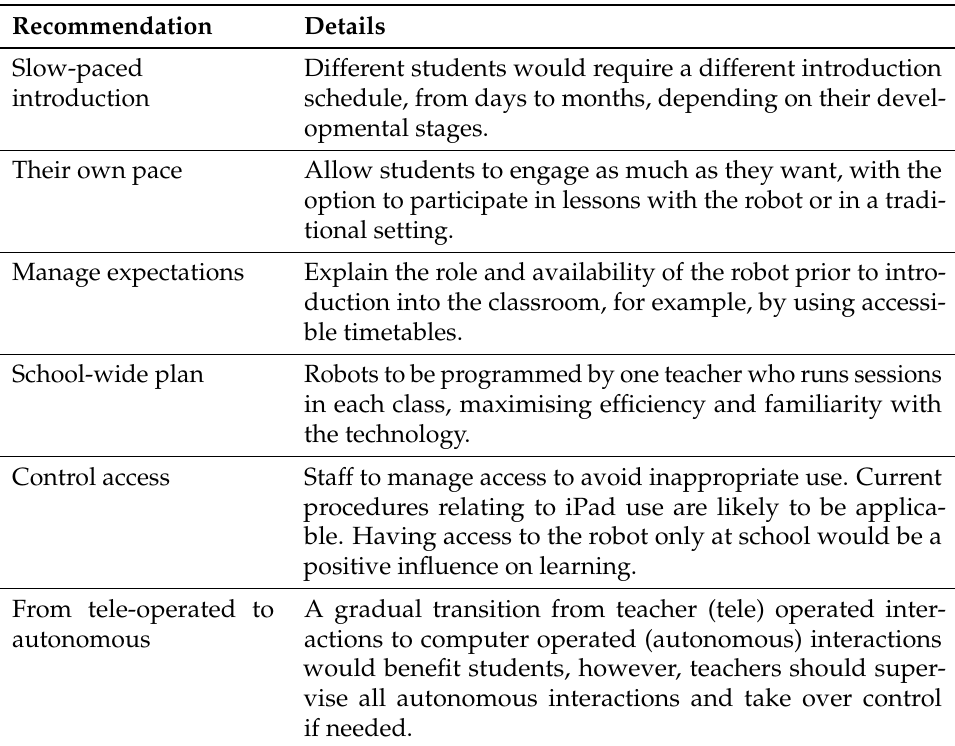
Table 7. Recommendations for integrating robots into the classroom.